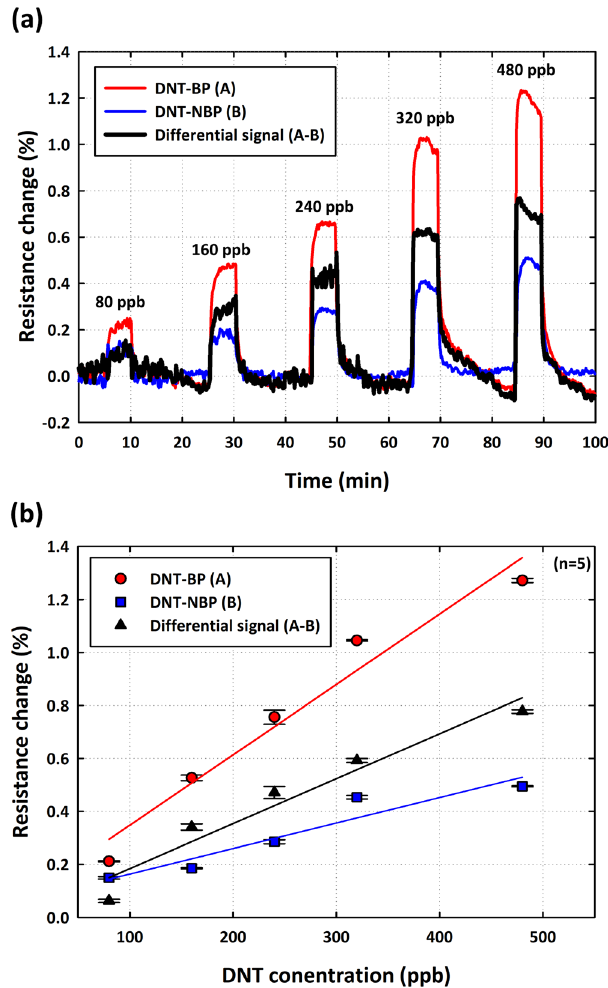
Figure 4. Sensitivity test: ( a ) Real-time monitoring of resistance change for different concentrations of DNT vapor. The sensing signals of both DNT-bp (red) and DNT-nbp (blue) were measured to calculate the differential signal (black). ( b ) Sensitivity results in ( a ) plotted as a function of the DNT concentration and the calculated differential, showing that the linear sensitivity of the differential signal was (0.17 ± 0.02) × 10 − 4 per ppb. The R-square values for DNT-bp, DNT-nbp and differential value are approximately 0.9590, 0.9091 and 0.9414,